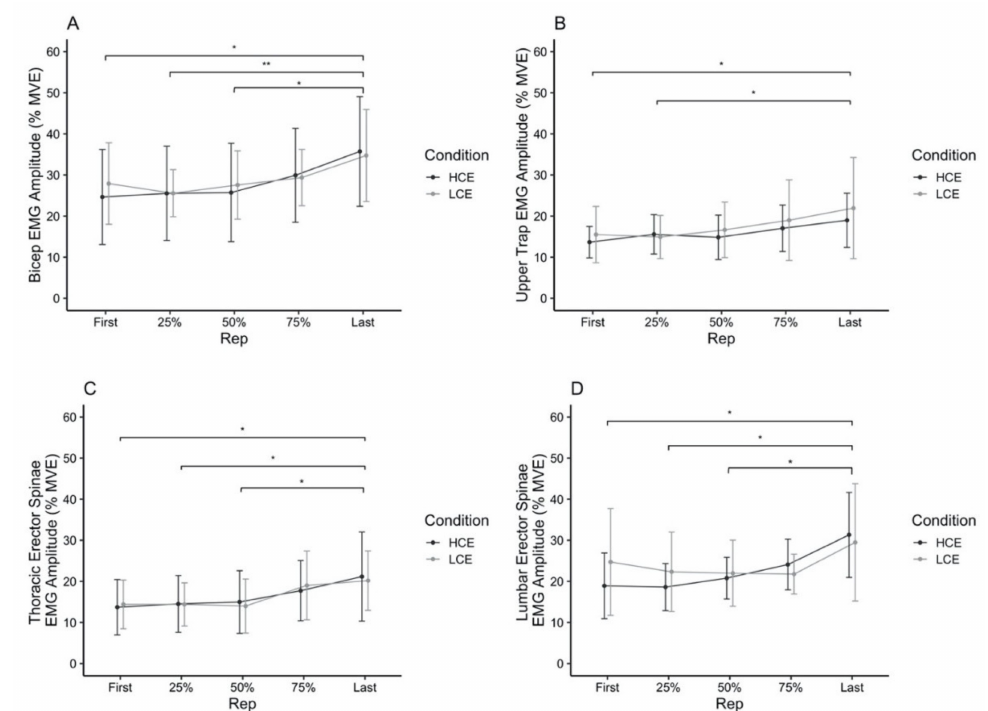
Figure 5. Iso-time average EMG amplitude (% maximum voluntary exhaustion) for the dominant side biceps ( A ), upper trapezius ( B ), thoracic erector spinae ( C ) and lumbar erector spinae ( D ) muscles during the physical task, by condition. Data points represent means with standard deviation error bars. LCE = low cognitive exertion; HCE = high cognitive exertion. Significant comparisons (* p < 0.05, ** p < 0.001) are